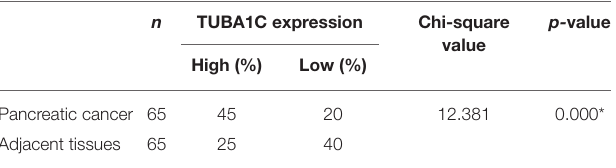
TABLE 1 | Differential expression of TUBA1C in pancreatic cancer and adjacent tissues. n